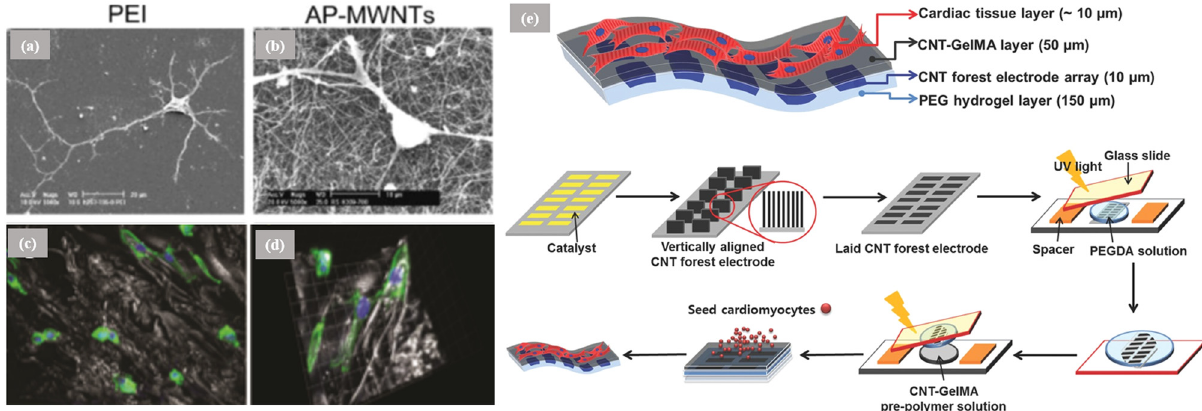
Figure 15: SEM images of neurons grown on polyethyleneimine ( a ) and MWCNT ( b ) [ 116 ] . Copyright 2015, Wiley. ( c ) Confocal microscopy images of osteoblasts attached on 10% nHA chitosan sca ff old and ( d ) 3D morphology of attached cells [ 117 ] . Copyright 2019, Springer Nature. ( e ) A diagram exhibiting the synthesis process to produce 3D actuators composed of a multilayer hydrogel sheet impregnated with VACNT microelectrodes [ 118 ] . Copyright 2006, Springer